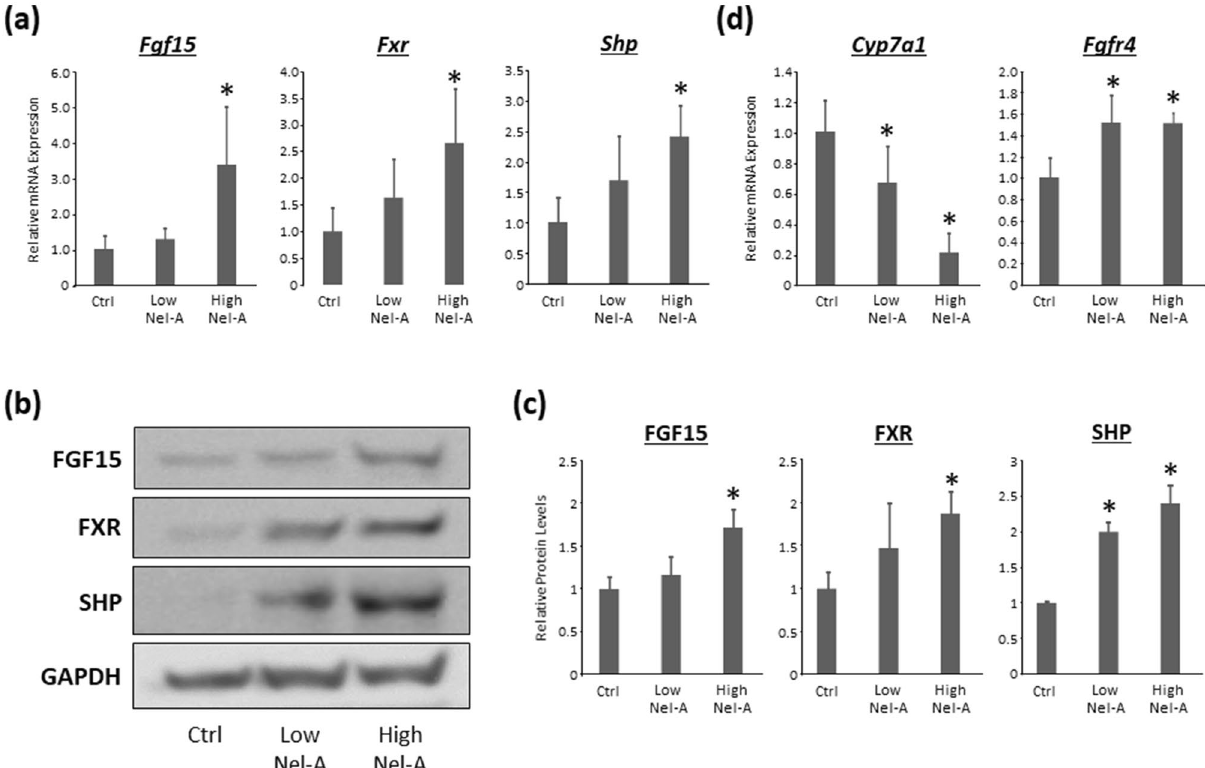
Figure 4. Effects of nelumal A on FXR signals in the ileum and FGF pathways in the liver in the colon of carcinogenesis model mice. ( a ) The mRNA expression levels of Fgf15 , Fxr , and Shp in the ileum were measured by quantitative real-time reverse transcription PCR with specific primers. Parallel amplification of 18S was used as the internal control. Statistical analyses were performed using one-way ANOVA followed by Tukey–Kramer multiple comparison test. n = 6. ( b ) Total proteins were extracted from the ileum samples of experimental mice, and protein levels of FGF15, FXR, and SHP were examined by western blot analysis using specific antibodies. GAPDH served as the loading control. ( c ) The bar graphs show the mean intensities of each protein. Statistical analyses were performed using Kruskal–Wallis test and following Steel–Dwass test. n = 4. ( d ) The mRNA expression levels of Cyp7a1 and Fgfr4 in the liver were measured by quantitative real-time reverse transcription as described above. Statistical analyses were performed using one-way ANOVA followed by Tukey–Kramer multiple comparison test. n = 6. Each column represents the mean ± SD. Asterisk indicates statistically significant differences compared to AOM/DSS-treated control group; P < 0.05. Ctrl, control. Nel-A, nelumal